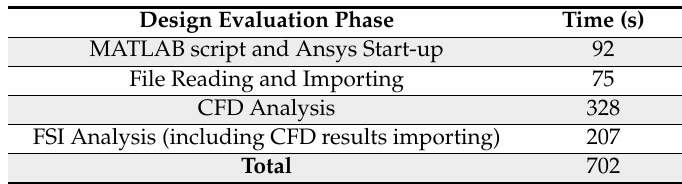
Table 3. Design evaluation timings.